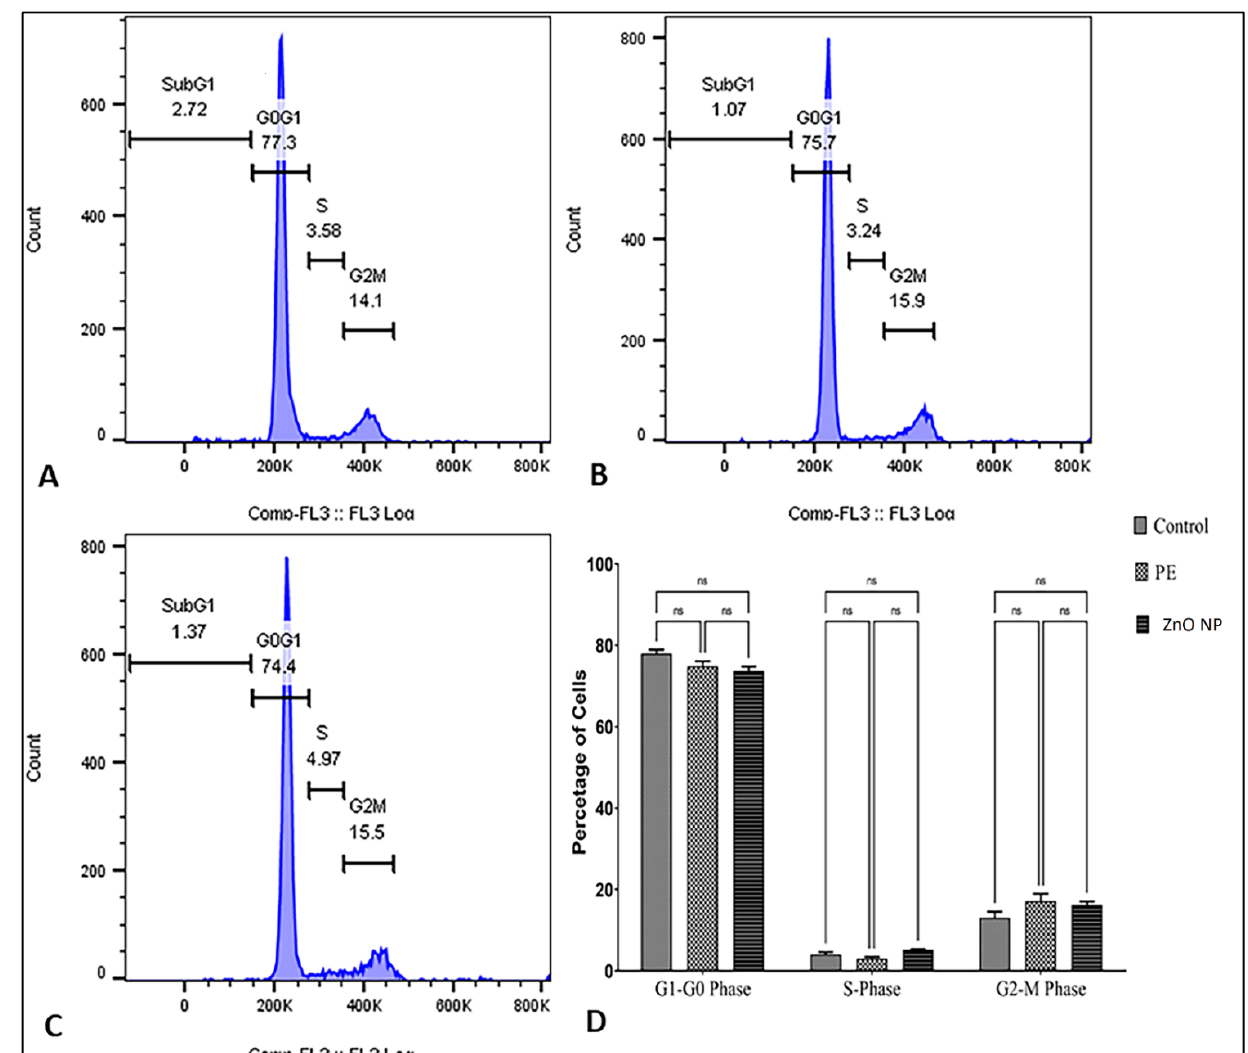
Figure 12. Cell Cycle Analysis by flow cytometer in PE and ZnONPs-treated MCF cells ( A ) Untreated control cells, ( B ) Cells treated with PE, ( C ) Cells treated with ZnONPs. ( D ) Bar graph for cell cycle arrest.